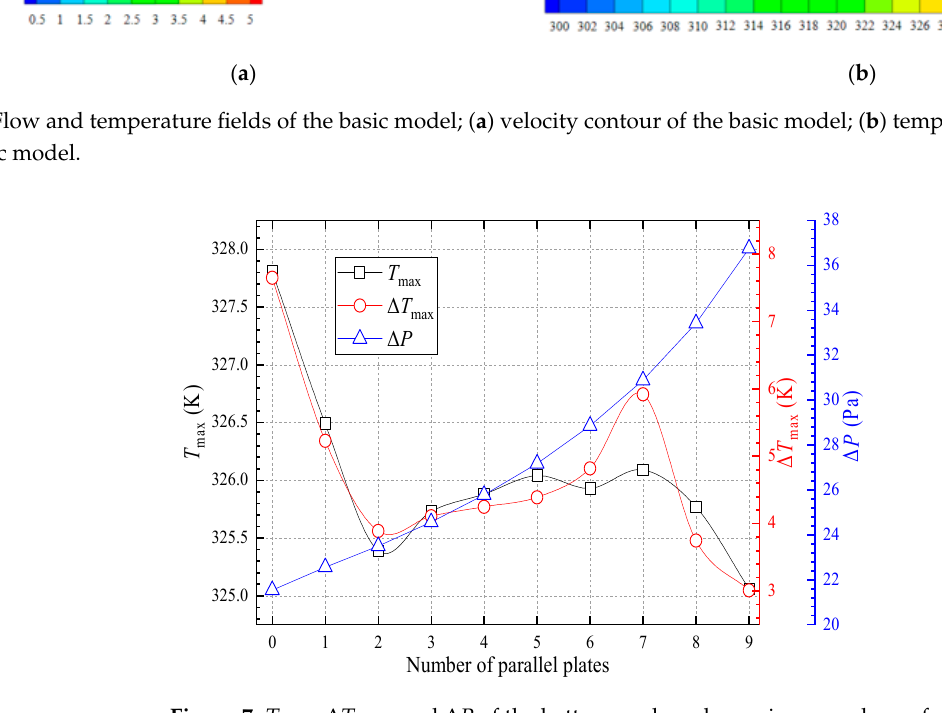
Figure 7. T max , ∆ T max , and ∆ P of the battery pack under various numbers of parallel plates.